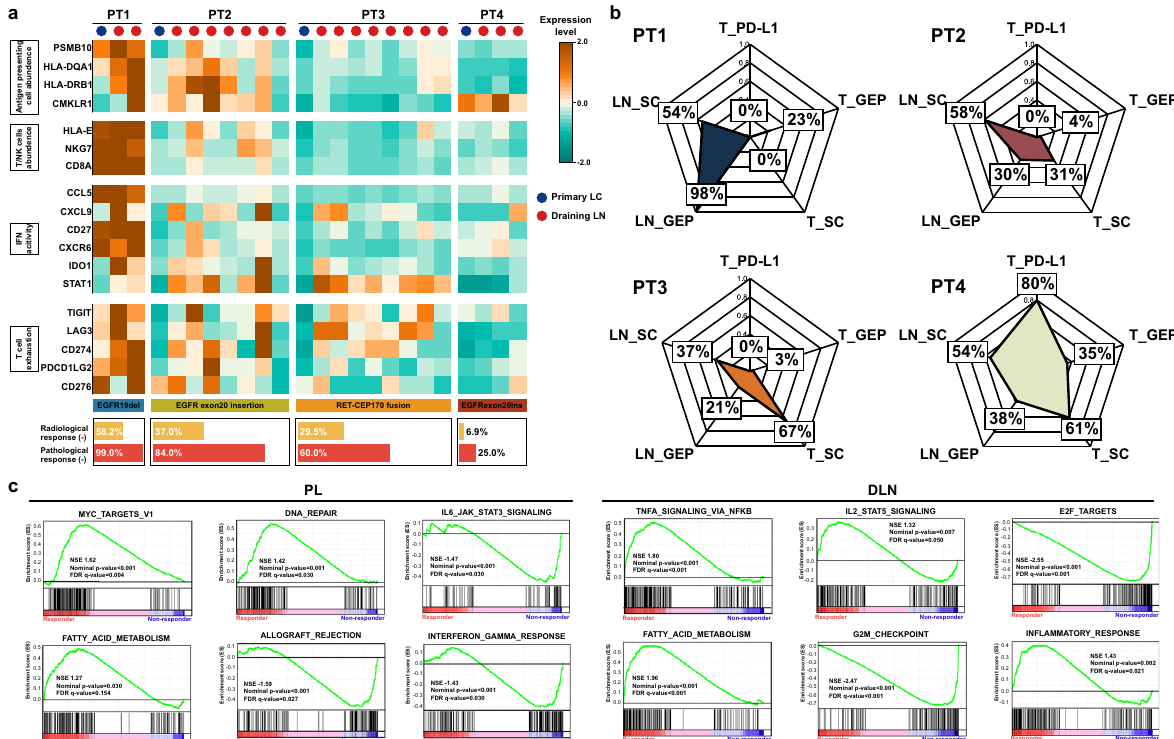
Fig. 4 Immune phenotypes and enriched functional pathway among PLs and DLNs. a Expression pro fi le of functional genesets including antigen presenting cell abundece, T/NK cell abundence, IFN activity and T cell exhasution were presented through z-score. b Radar plots of comprehensive immune phenotypes including PD-L1 expression in PL, T-cell in fl amed GEP and suppressor cell score in PL and DLNs were scaled into 0 – 100%. T_PD-L1 represents expression of PD-L1 in tumor; T_GEP represents gene-expression pro fi le of in fi ltrating lymphocytes in tumor; T_SC represents suppressor cell in tumor; LN_GEP represents gene-expression pro fi le of in fi ltrating lymphocytes in draining lymph nodes; LN_SC represents suppressor cell in draining lymph nodes. c Gene set enrichment analysis (GSEA) of PL and DLNs upon responders and